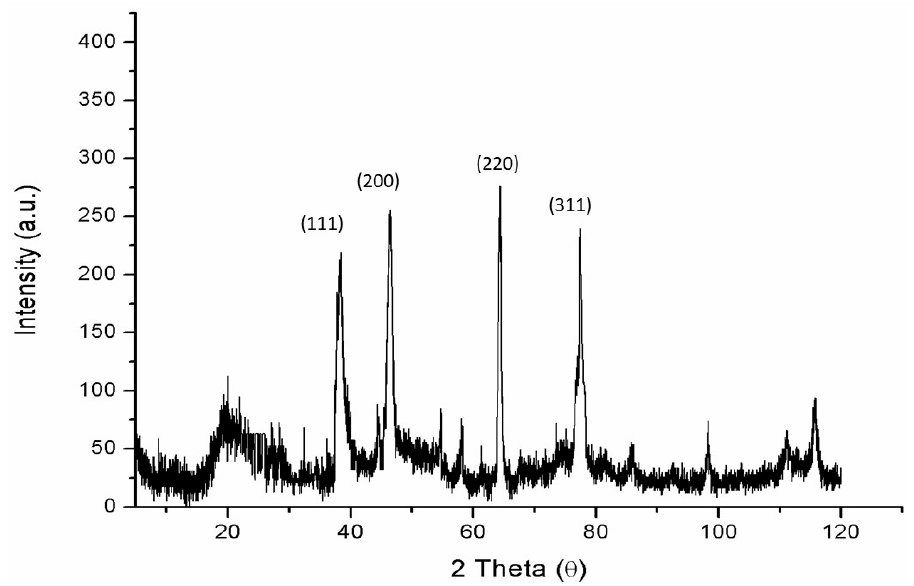
Figure 4. XRD patterns of nanoxylan .